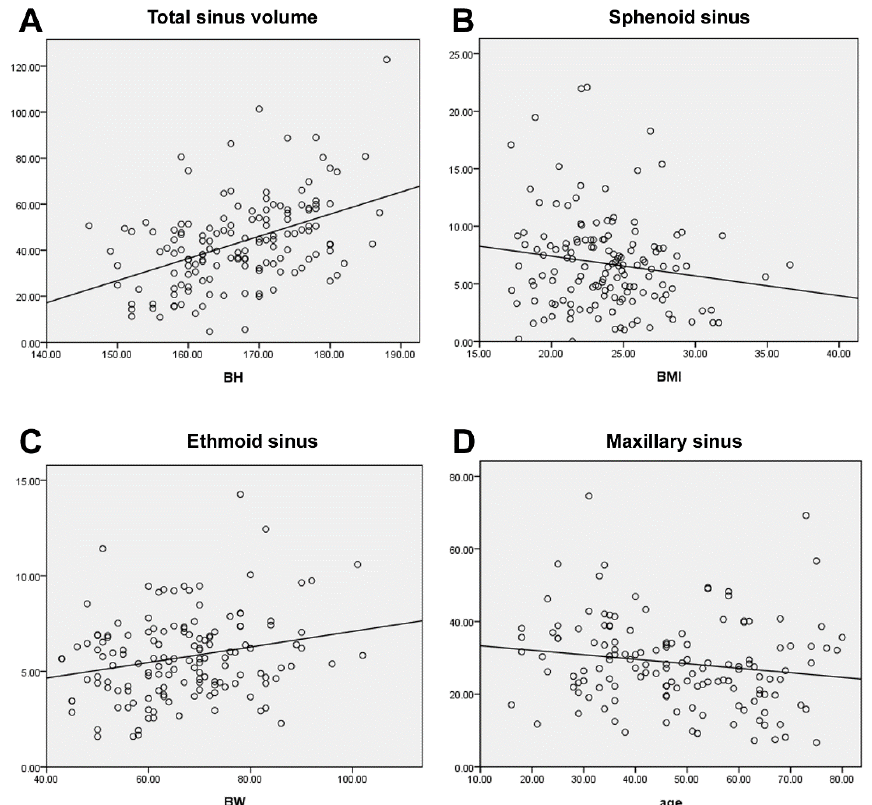
Figure 3. ( A ). A significant positive correlation was found between sinus volume and body height ( p < 0.001). The volume had no significant correlations with BMI ( B ) ( p = 0.067) and weight, except for the ethmoid sinus ( C ) ( p = 0.005). ( D ) A trend toward negative relation between maxillary sinus volume and age ( p = 0.053). Table 4. Sidal difference (left/right) subdivided between genders (one-way ANOVA). Max: maxillary Table 3. Mean values of the metrical characteristics and volume dispersion by sex, and results of the comparison between groups. sinus, AE/PE: anterior/posterior ethmoid sinus, Fro: frontal, Sph: sphenoid sinus. Overall Male Female p -Value Left/Right Overall Male Female Max 101.69 ±